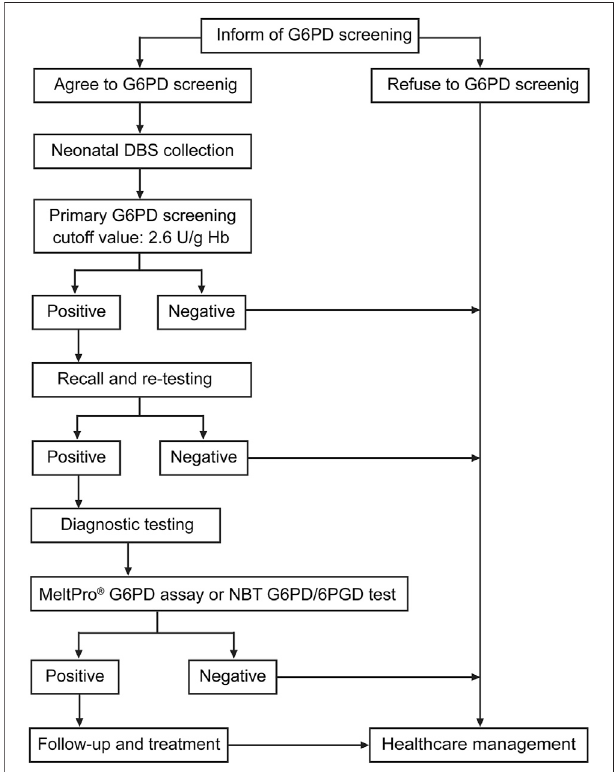
FIGURE 1 | Flowchart for screening newborns and diagnosis of G6PD de fi ciency. Recall and re-testing were conducted using a new dried blood spot (DBS), whereas con fi rmatory testing was conducted using a peripheral blood sample from the